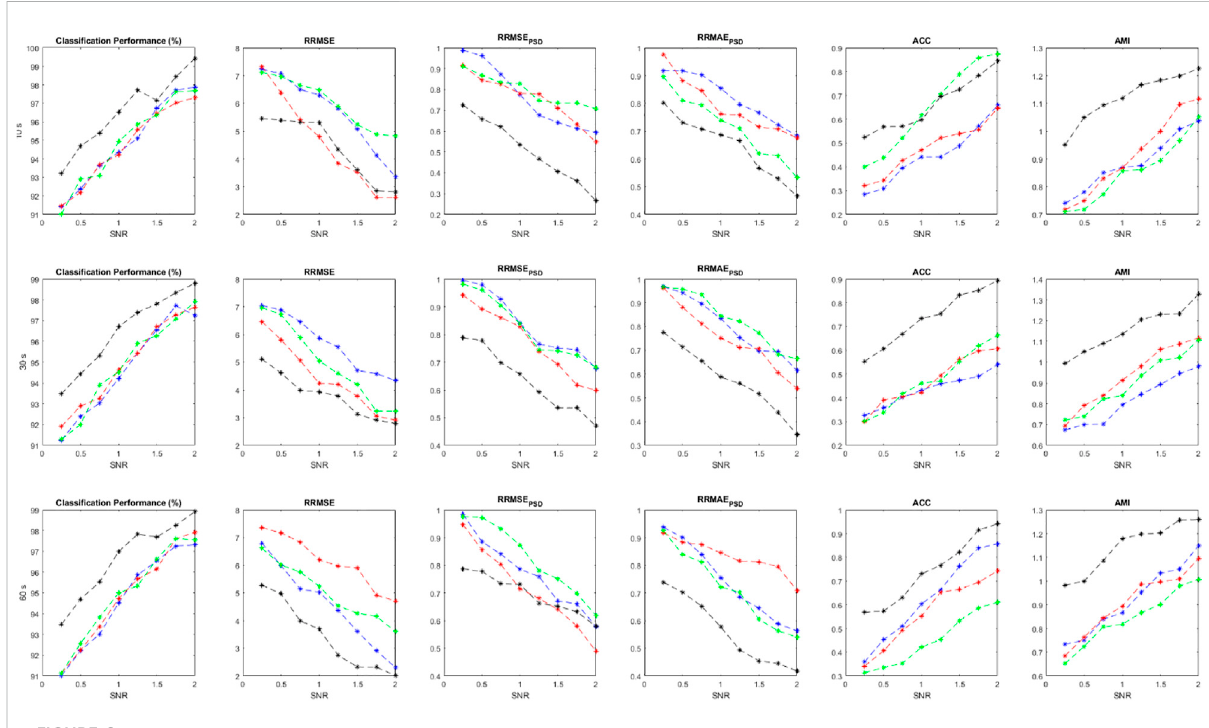
FIGURE 6 Performance measures for SSCEEG1 using evaluation criteria including ACP , RRMSE , RRMSE PSD , RRMAE PSD , ACC , and AMI